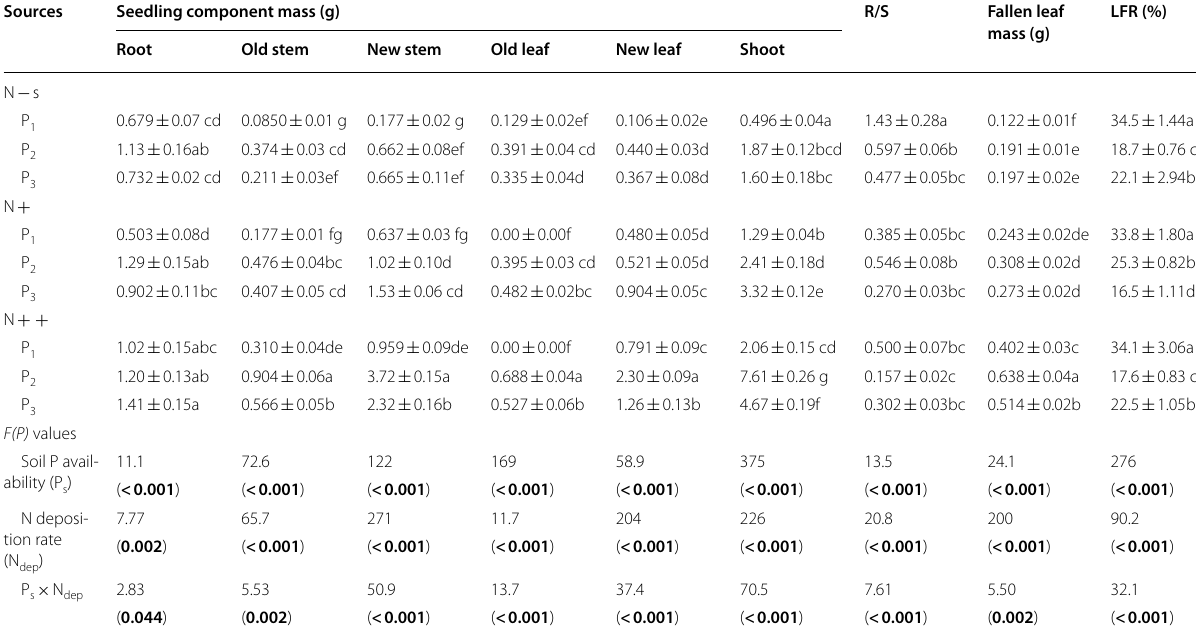
Table 1 Analysis of variance for the effects of soil P availability (P ), N deposition rate (N s seedling component mass and the related morphology traits (i.e., fallen leaf ratio (LFR), root to shoot ratio (R/S)) of P. edulis seedlings at the time of final harvest (May 7, 2019). N-, N , and N represent 0, 30, and 60 kg N + + + respectively; P , P , and P represent 2.99, 20, and 40 mg kg − 1 of soil available P content, respectively. Statistically significant effects 1 2 3 · ( P < 0.05) are highlighted in bold text